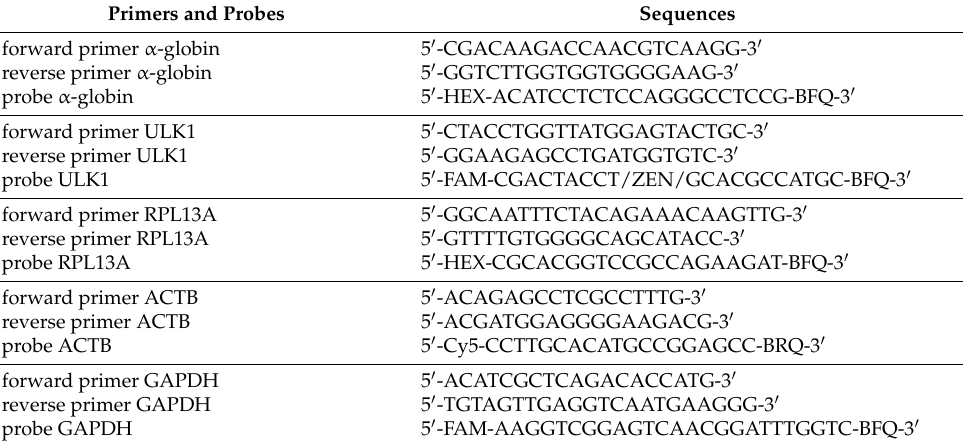
Table 1. List of primers and probes with related sequences used to perform RT-qPCR